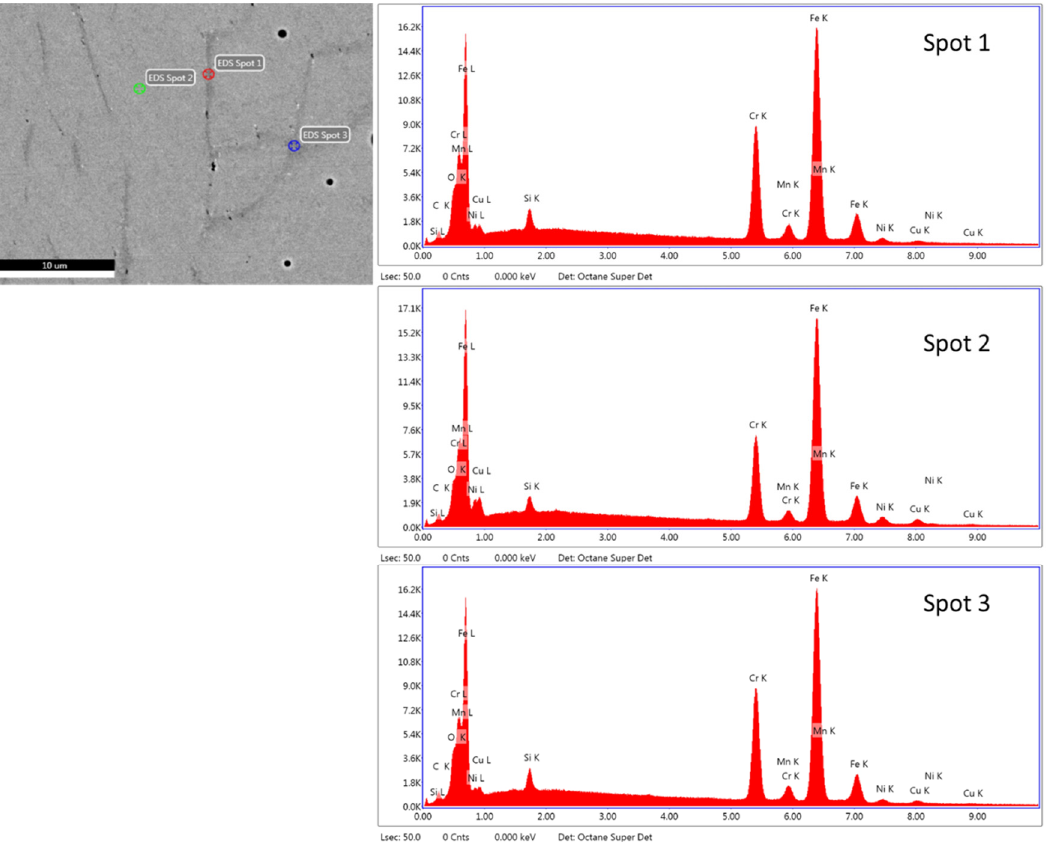
Figure 11. SEM image and EDS analysis of the PMD specimen built in air and thermally treated with TT1.